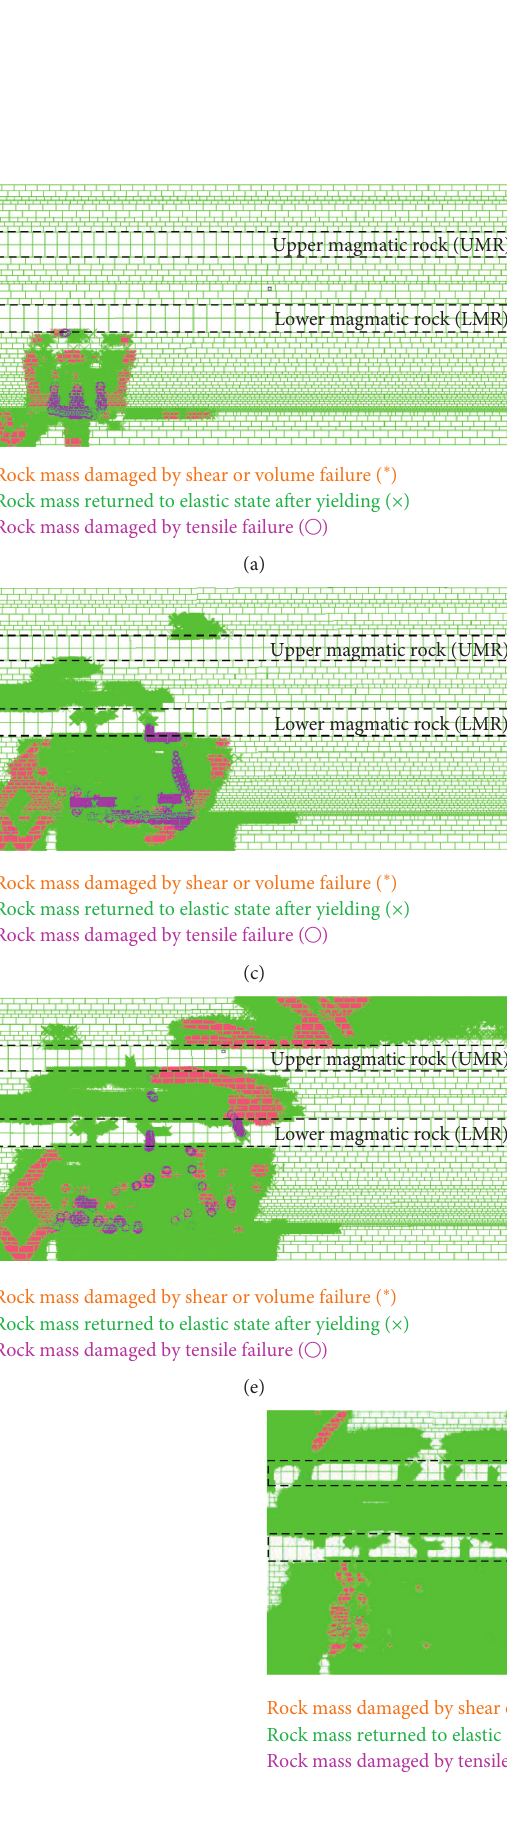
Figure 4: Variation of plastic zone during the mining process. (a) 70m. (b) 160m. (c) 190m. (d) 220m. (e) 250m. (f) 370m. (g)